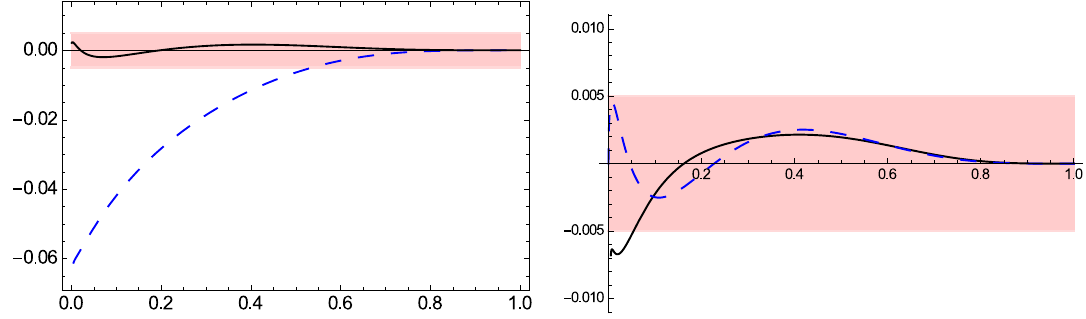
( x ) =H (3+) ( x ) (dashed curve) for exact splitting func- inv inv j (cid:12)t (cid:0) (cid:14)H (3+) j exact ) =H (3+) (solid inv inv inv